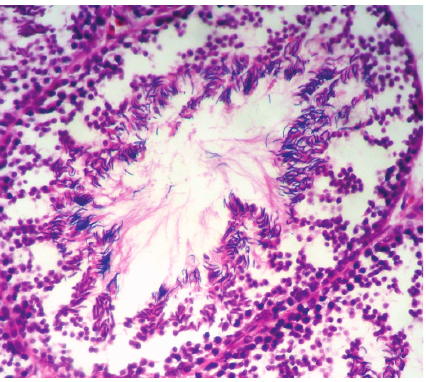
Figure1:Seminiferoustubulesof Phrynocephalusmaculatus inMay.